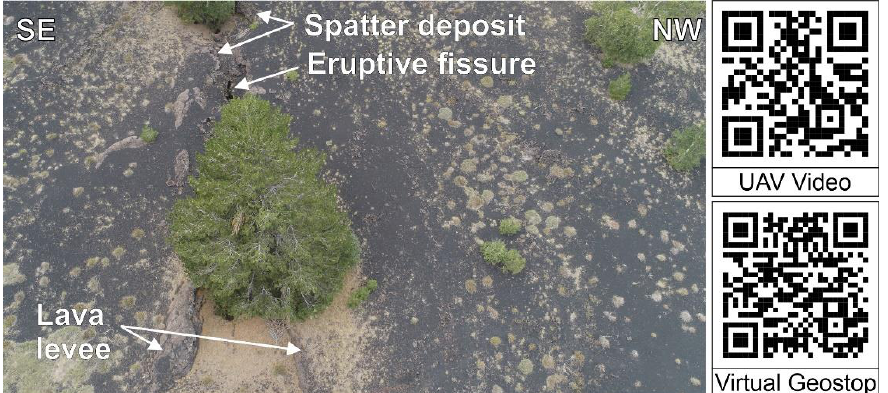
Figure 8. The image on the left shows geostop 6 through a SW-looking UAV-captured picture. The QR codes on the right enable opening the corresponding UAV-captured video and the related VG. By using a mobile phone or a tablet, open up the QR code reader. Hold your device over a QR code, so that it is clearly visible on your screen. Press the notification and wait a few seconds.